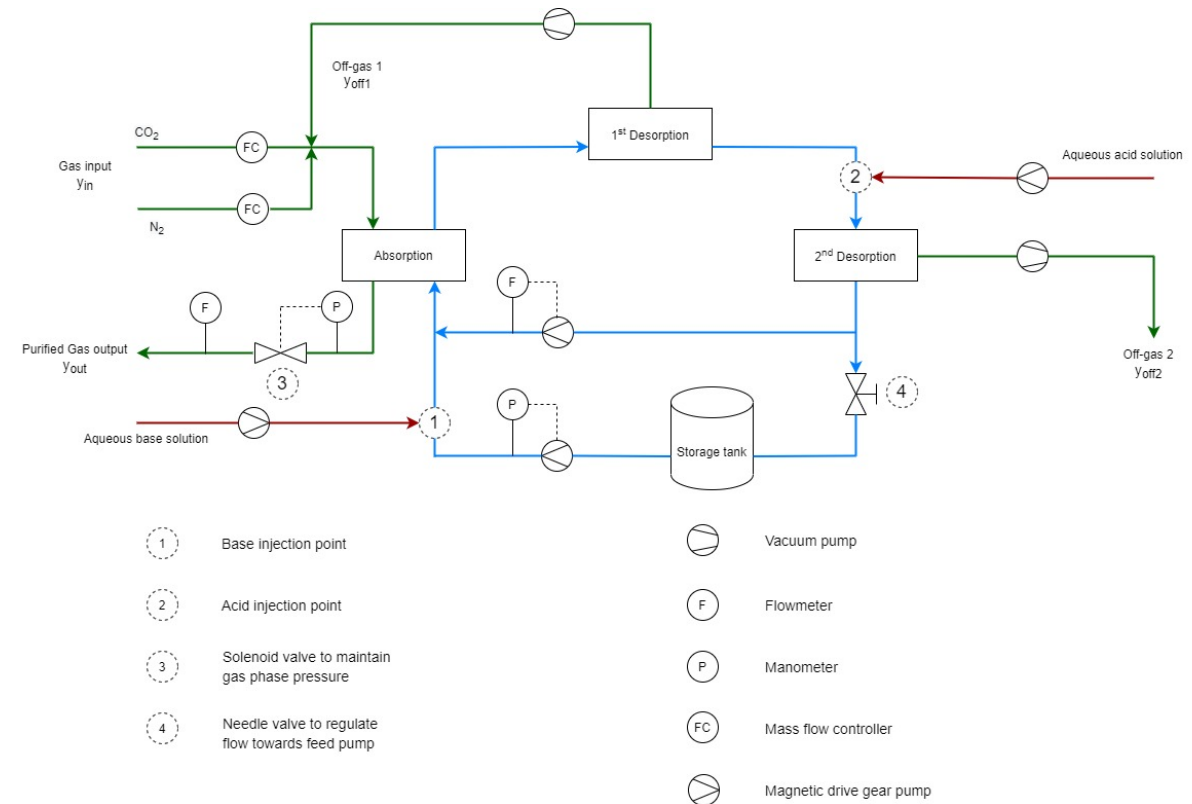
Figure 1. A schematic diagram of Hollow Fiber membrane contactor (adapted from Liqui-Cel ® man- ual) [34].